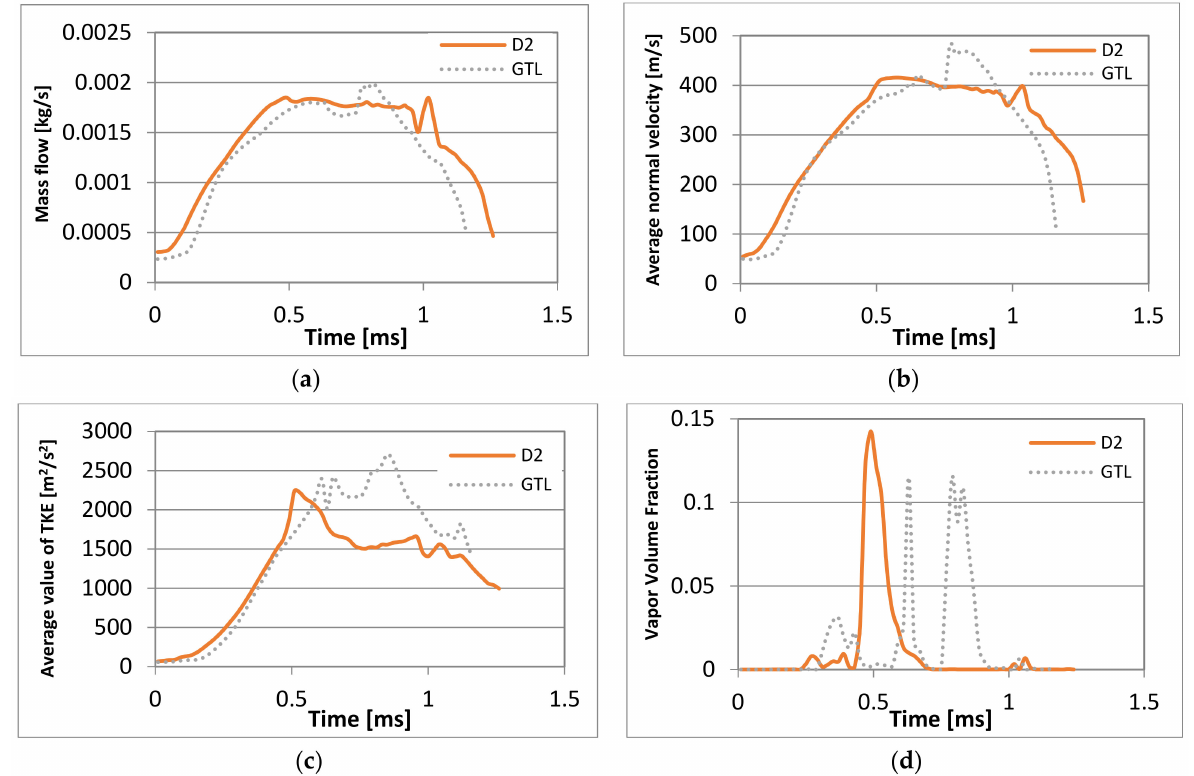
Figure 10. Outlet integral quantities for 1 of the injection hole: ( a ) Mass flow rate; ( b ) Average normal velocity; ( c ) Average 2 value of liquid turbulent kinetic energy; ( d ) Maximal value of Vapor Volume